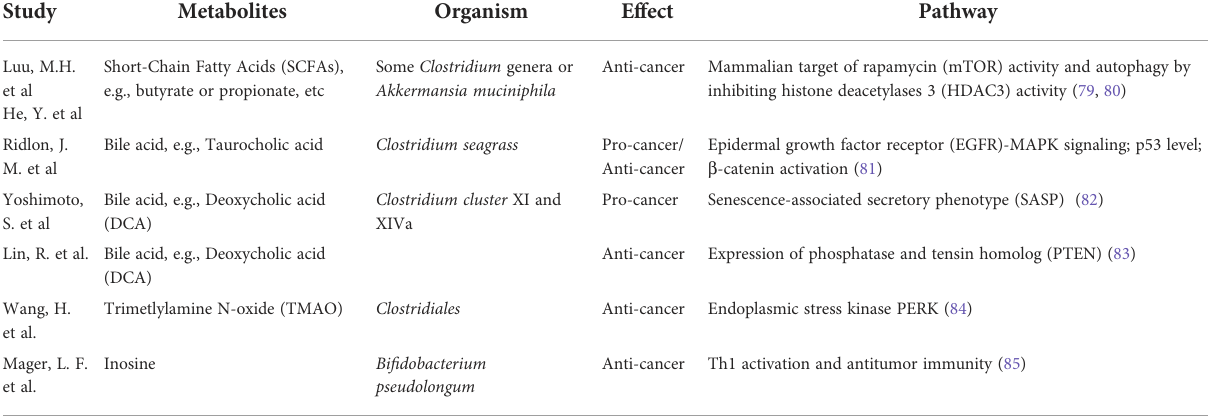
TABLE 2 The metabolites of gut microbiota in